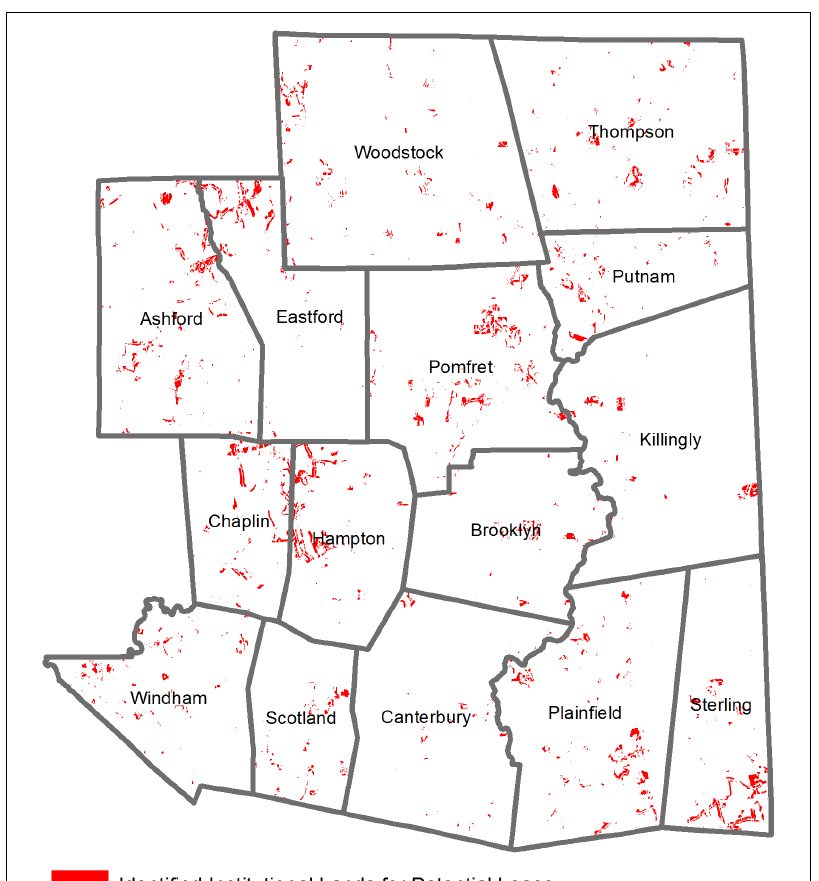
Figure 2. Institutionally Owned Lands in Windham County Identified by Site Suitability Analysis with Constraints